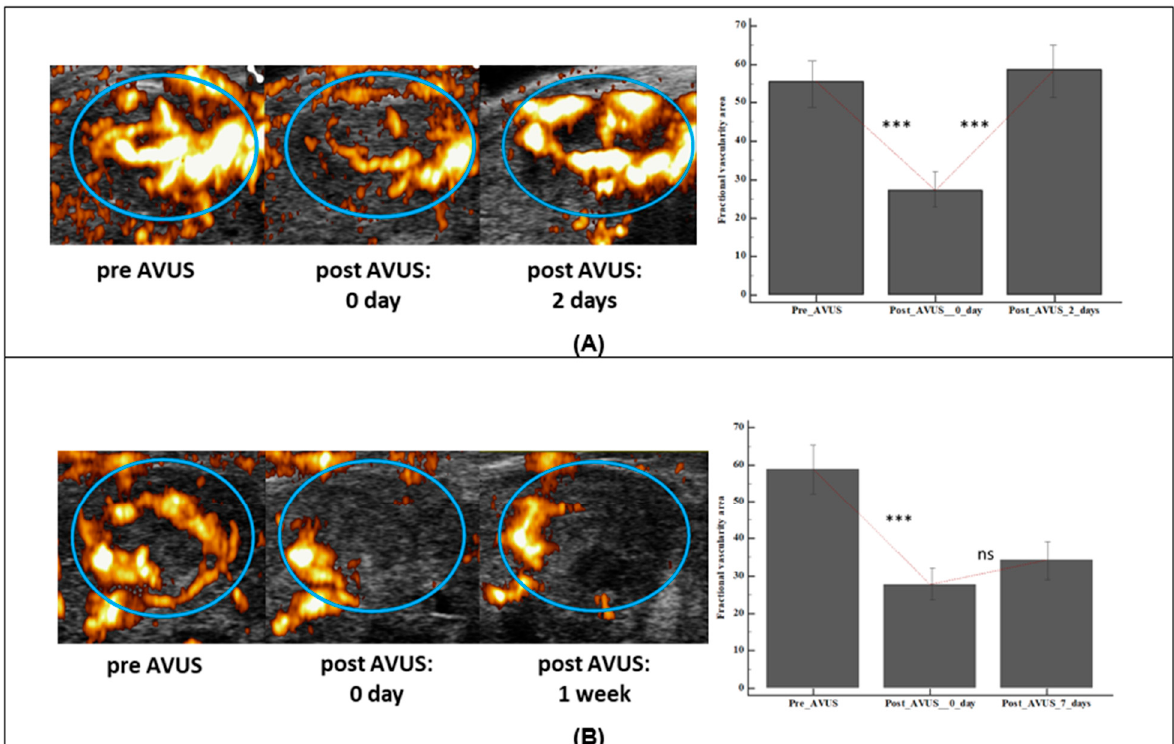
Figure 8. The changes in HCC tumor vascularity with time after 1st AVUS therapy in 2DST and 7DST groups. The upper panel ( A ) shows an example HCC tumor from the 2DST group that showed a reduction in vascularity immediately after therapy, and when followed two days later, tumor vascularity increased again to same level of baseline. The bar graph on the side shows the change in the vascularity area (VAR) for all 2DST tumors after first therapy. In the lower panel ( B ) an example of an HCC tumor that was followed a week later after therapy. No gain was observed in vascularity level from post therapy one week later. *** represent significant difference, while ns means not significant.